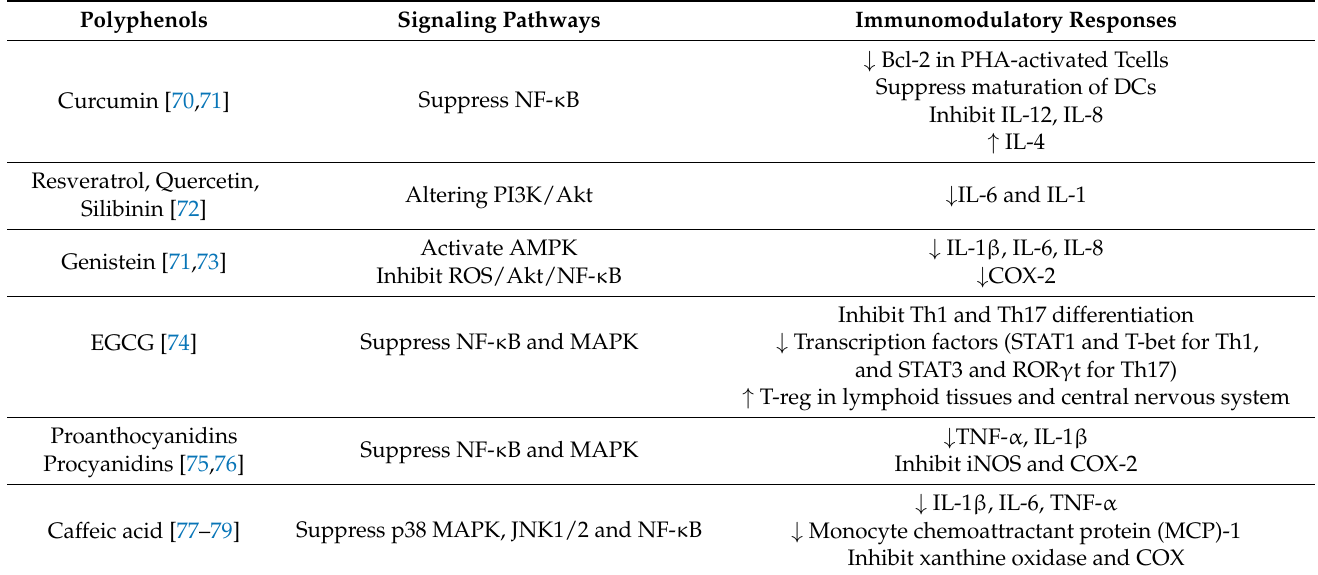
Table 1. The immunomodulatory effects of